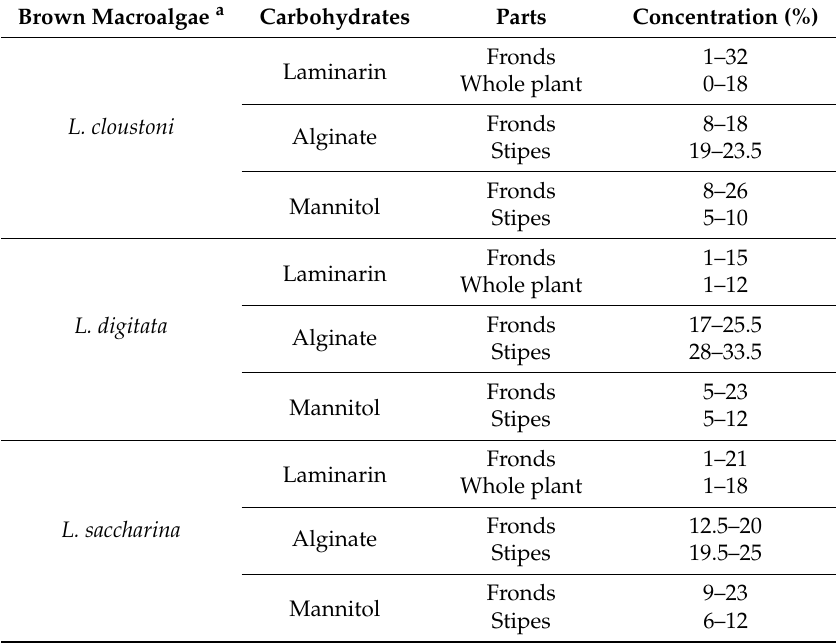
Table 3. Carbohydrates in brown macroalgae